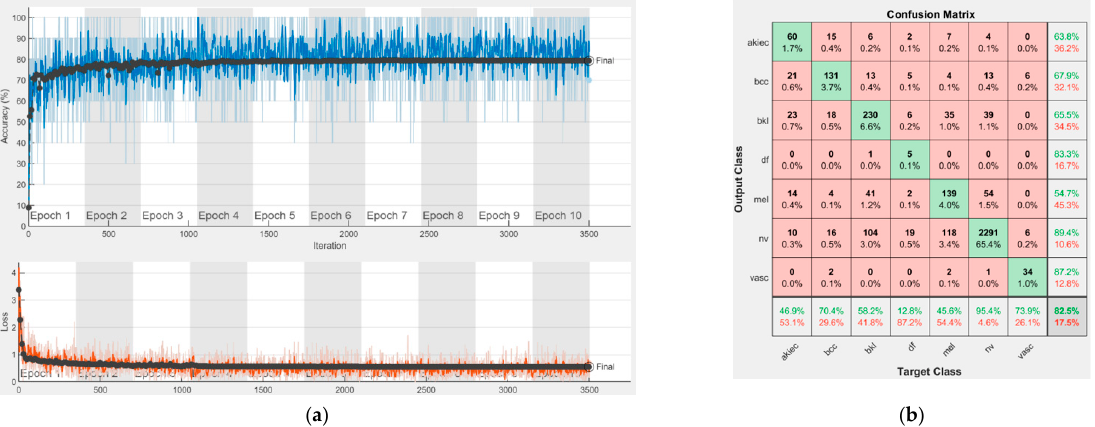
Figure 10. Results using GoogLeNet pre-trained on Places365, ( a ) Accuracy and loss, ( b ) Confusion matrix.